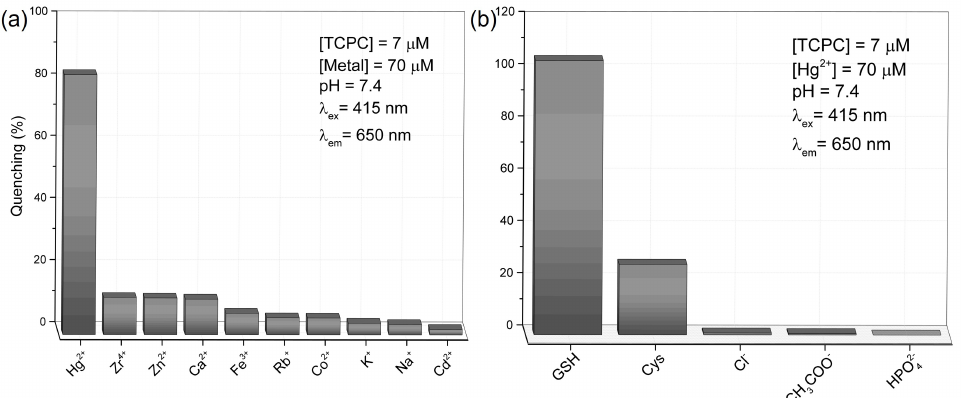
Figure 7. ( a ) Fluorescence quenching of TCPC in the presence of different metal ions. The experimen- tal conditions are shown in the figure. ( b ) Recovery of the TCPC fluorescence when GSH, cys and other ions were added. The experimental conditions are shown in the figure. GSH and cys are in physiological concentration. Other ions are in 1 equivalent to the